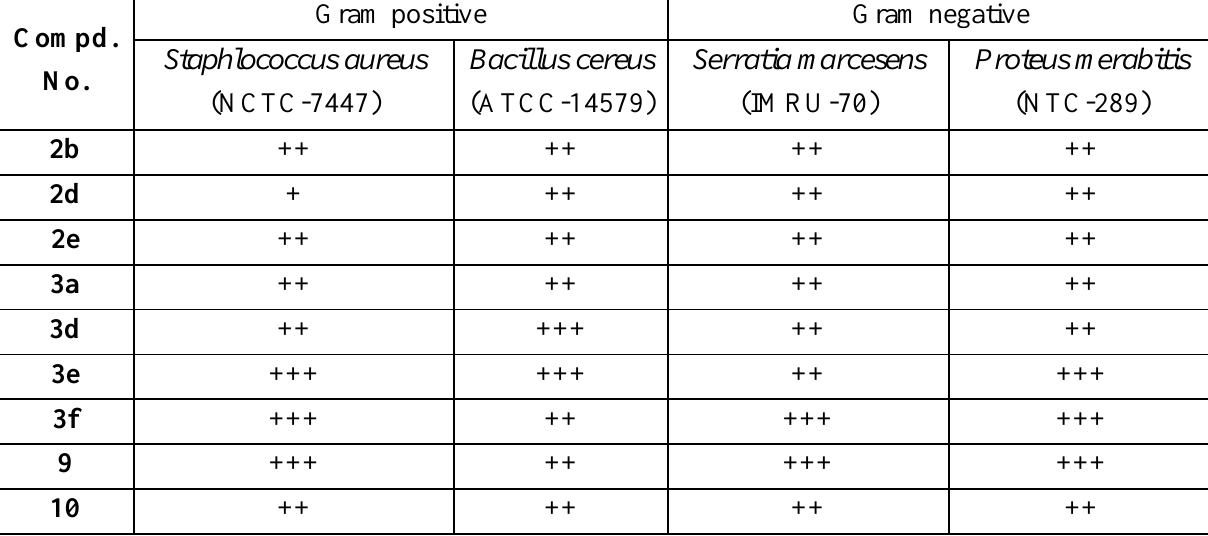
Table 1: Antimicrobial screen of the newly synthesized compounds Gram positive Gram negative